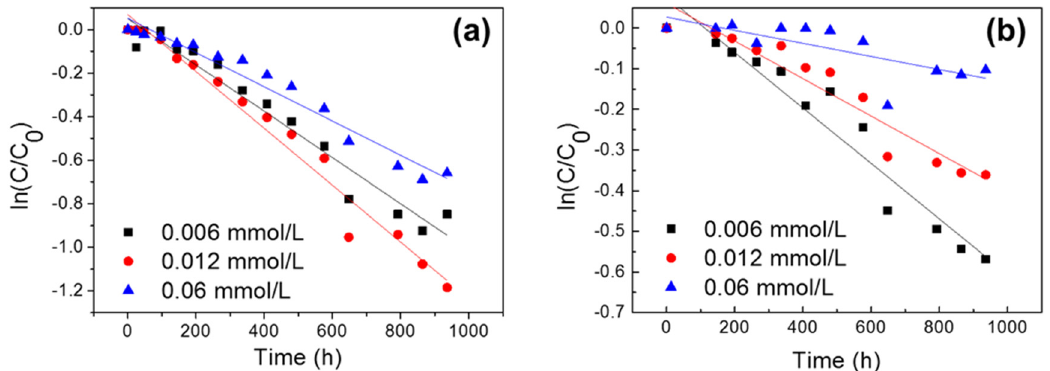
Figure 1. Effects of initial FQ concentration on the attenuation of ( a ) NOR and ( b ) LVF ( C , the concentration of FQs as a function of reaction time; C 0 , the initial concentration).